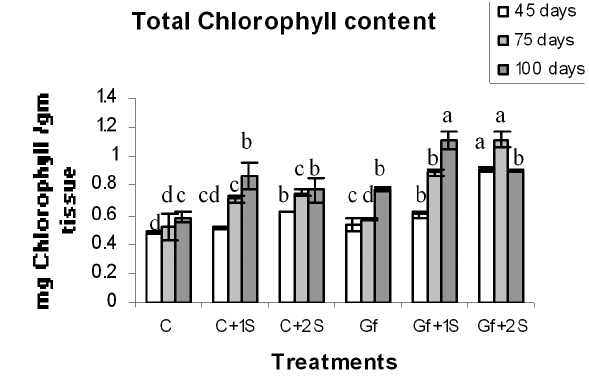
Fig. 2. Total chlorophyll content in Gmelina arborea Roxb inoc- ulated with Glomus fasciculatum after 45, 75 and 100 days after AM